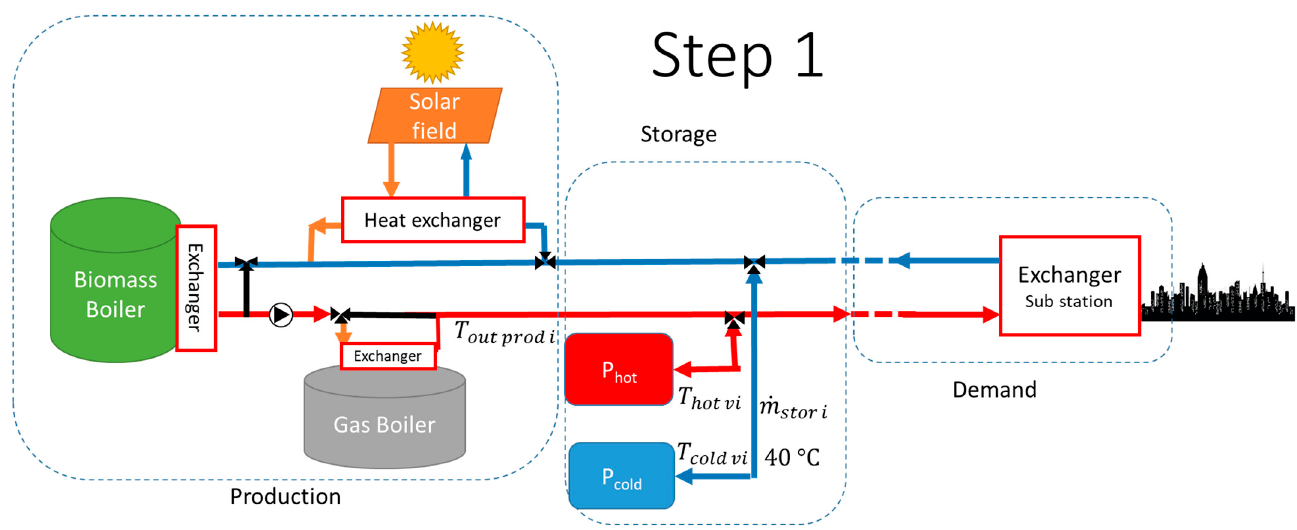
Figure 9. Step 1: Full DHN with simplified storage model.